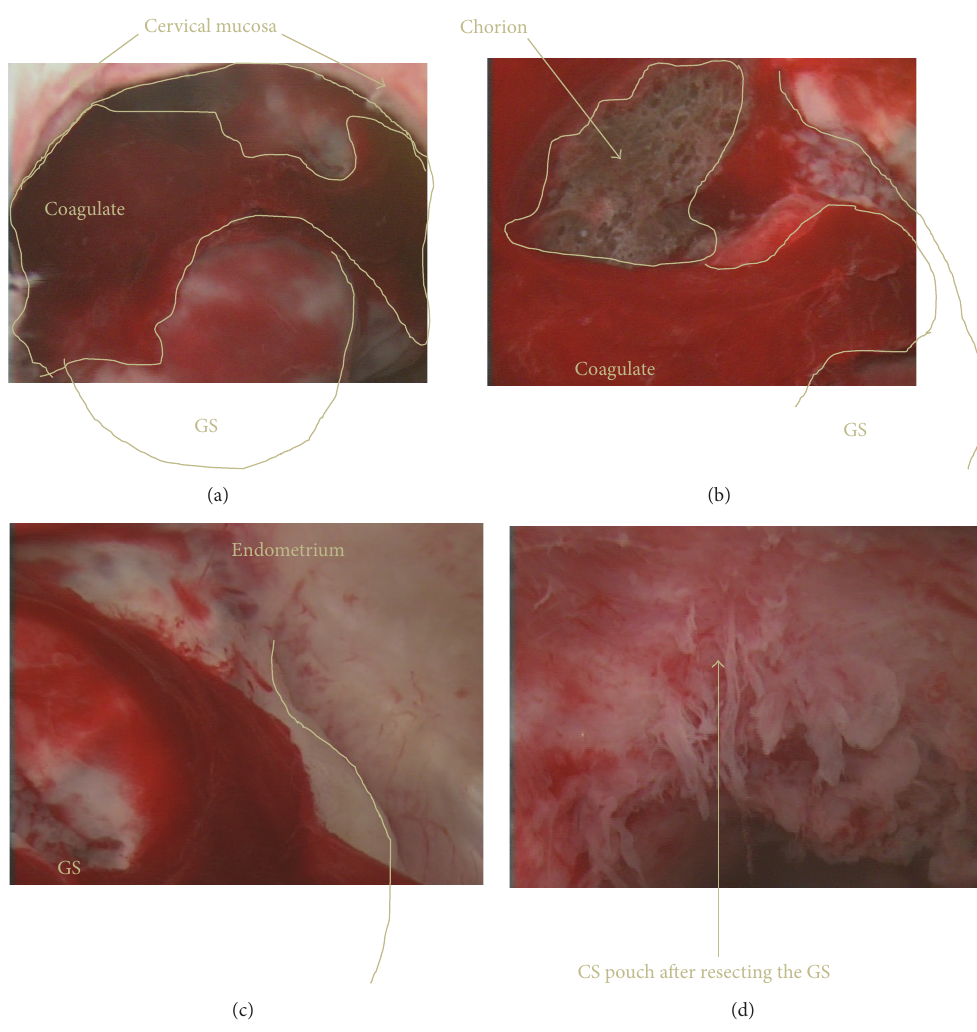
Figure 2: Hysteroscopic findings in cesarean scar pregnancy. (a) The round-shaped gestational sac (GS) was located in the cesarean scar pouch just beyond the cervical canal. The GS was partly covered with clotted blood. (b) The GS was attached to the cesarean scar pouch with chorionic tissue. (c) The GS was surrounded with thick endometrial glands. (d) The GS was resected in the cesarean scar pouch.